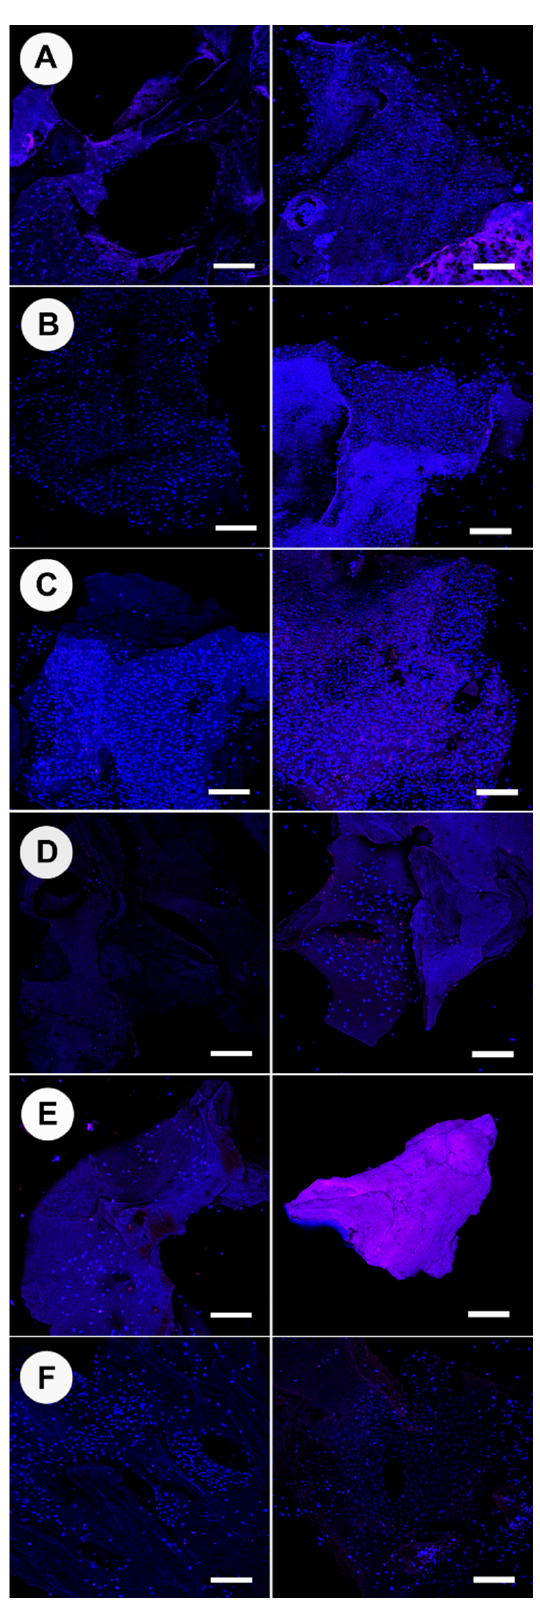
Figure 4. Confocal laser scanning microscopy (CLSM) of DAPI stained osteoblast nuclei (blue) at 7 (left) and 21 days(right) on bone scaffold specimens processed at 100 °C ( A ), 130 °C ( B ), 160 °C ( C ), 190 °C ( D ), 220 °C ( E ), Bio-Oss ® ( F ). Scale bar = 200 µm. Representative images of N = 3.